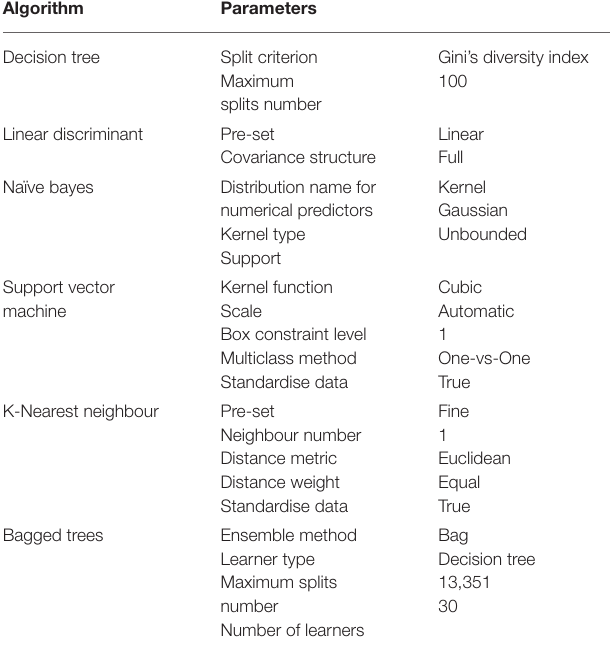
TABLE 5 | Classification algorithm